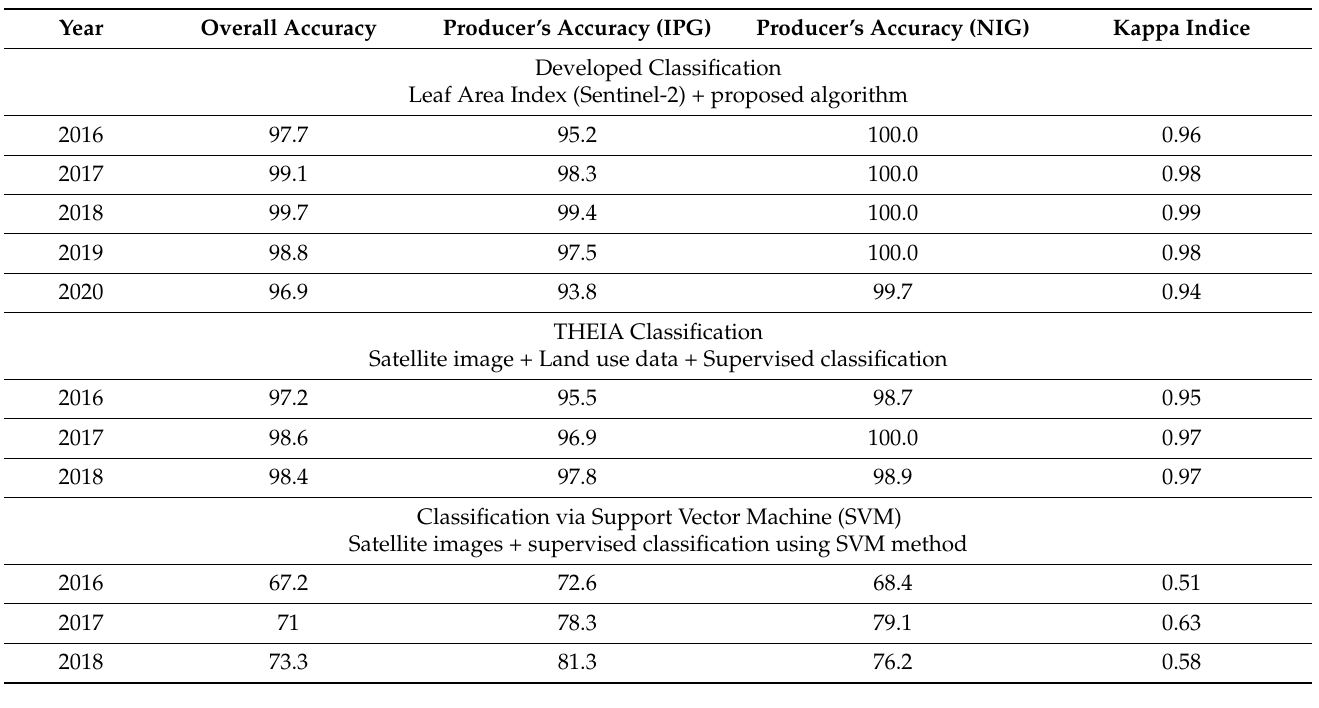
Figure 10. Observed (blue) and smoothed (orange) LAI time series of an IPG pixel showing four mowing events (green dots). Table 4. Summary of all the classification performances conducted in the Crau